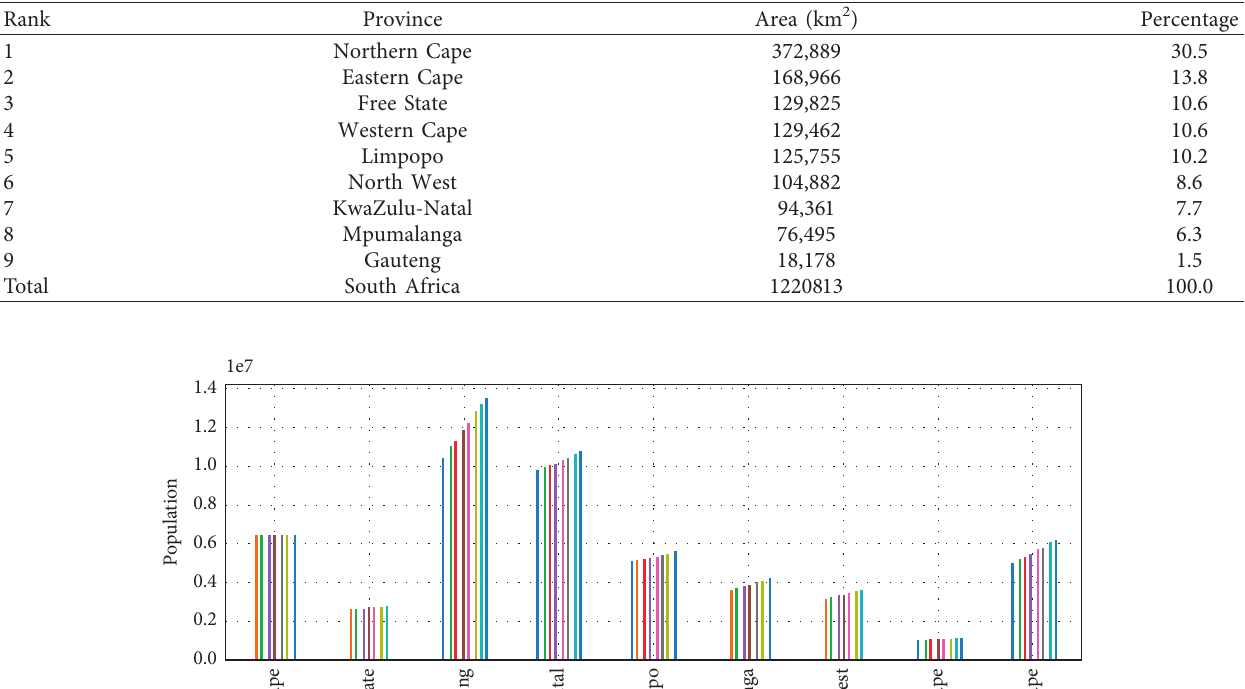
Table 2: Province area (km 2 ) [21].